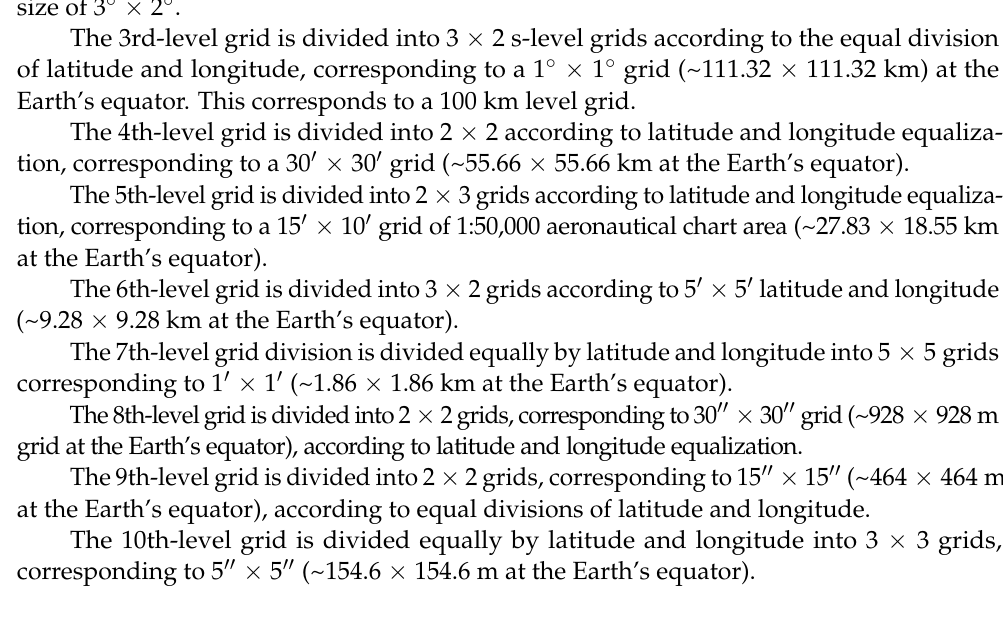
Figure 3. Multi ‐ level profiling process of GeoSOT ‐ AS planar dimension (4th–11th level profile). Figure 3. Multi-level profiling process of GeoSOT-AS planar dimension (4th–11th level profile). The 1st-level grid is divided according to the 1:1 million aeronautical chart, with a cell size of 6 ◦ × 4 ◦ , and is used as the basic framework for the national airspace management. The 2nd-level grid is divided according to the 1:500,000 aeronautical chart, with a cell size of 3 ◦ × 2 ◦